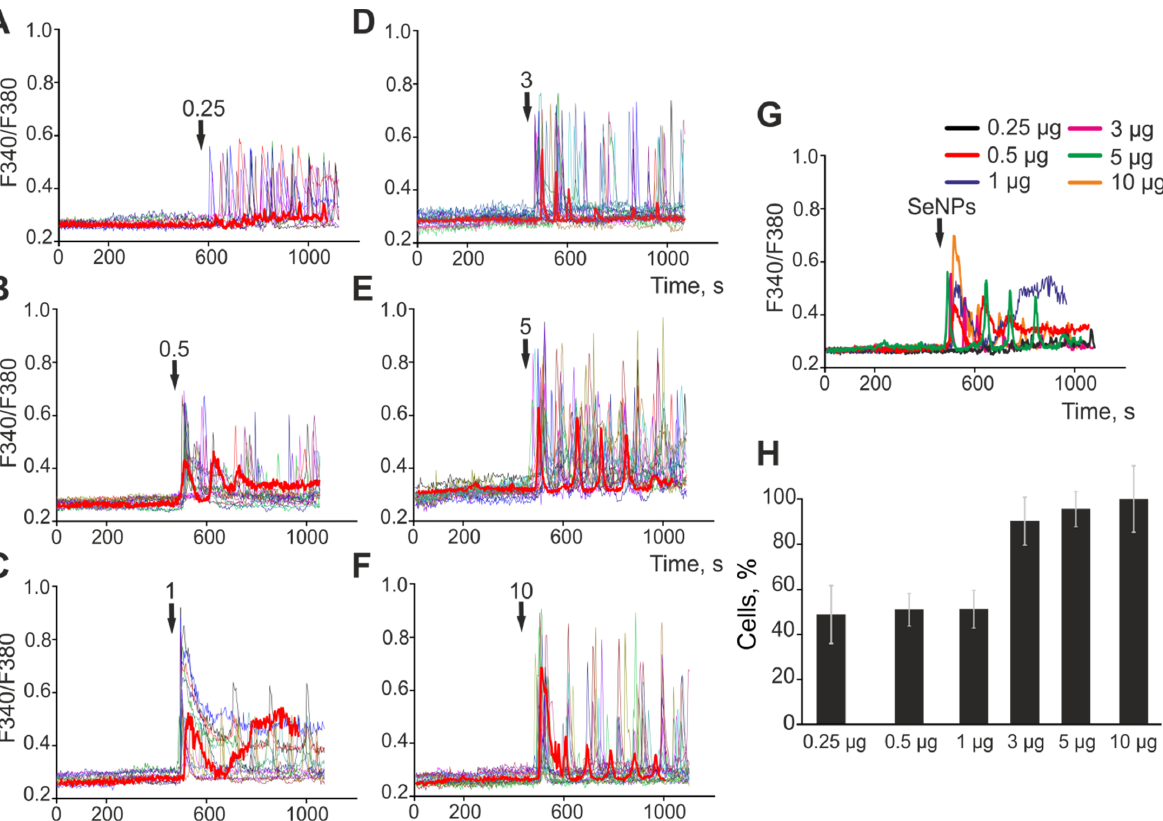
Figure 2. Application of various concentrations of 100 nm-sized SeNPs induces the generation of Ca 2+ signals in astrocytes of the cerebral cortex. ( A – F )—Ca 2+ signals of individual astrocytes in one experiment and their average value (red curve) for the application of increasing concentrations of SeNPs. ( G )—Astrocytic Ca 2+ signals averaged over several tens of cells for the application of increasing concentrations of 100 nm-sized SeNPs. ( H )—The percentage of astrocytes that respond with Ca 2+ signals to the application of SeNPs. The arrow indicates the moment of SeNPs application and their concentration in micrograms per mL ( μ g/mL).